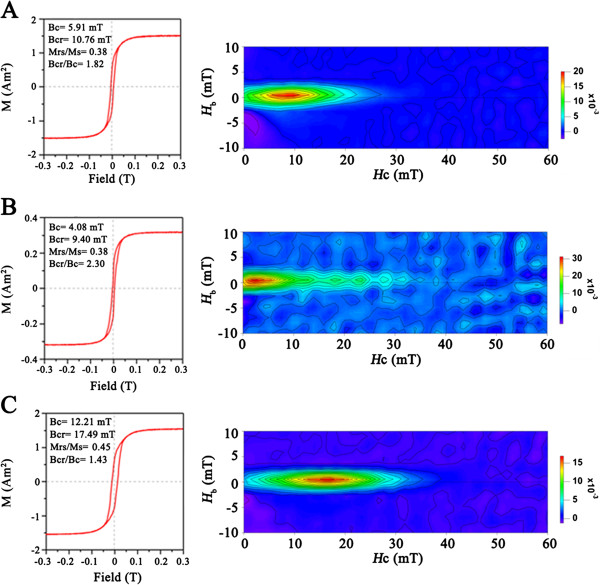
Measurements of magnetism in deferent cells. (A):WT, (B): ΔmamX and (C): CmamX. Left: room-temperature hysteresis loops. Right: FORCs diagrams.